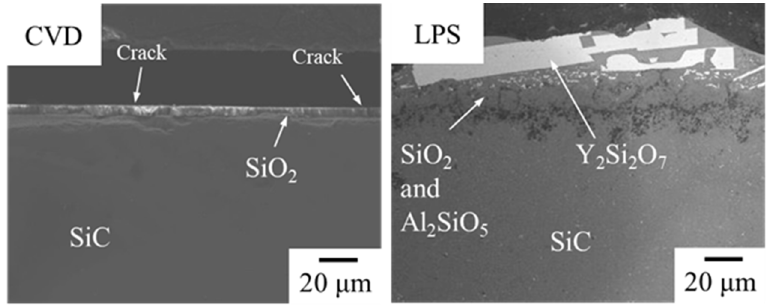
Figure 3. SEM images of cross-section of the CVD SiC and the LPS SiC following steam oxidation for 72 h at 1400 °C.